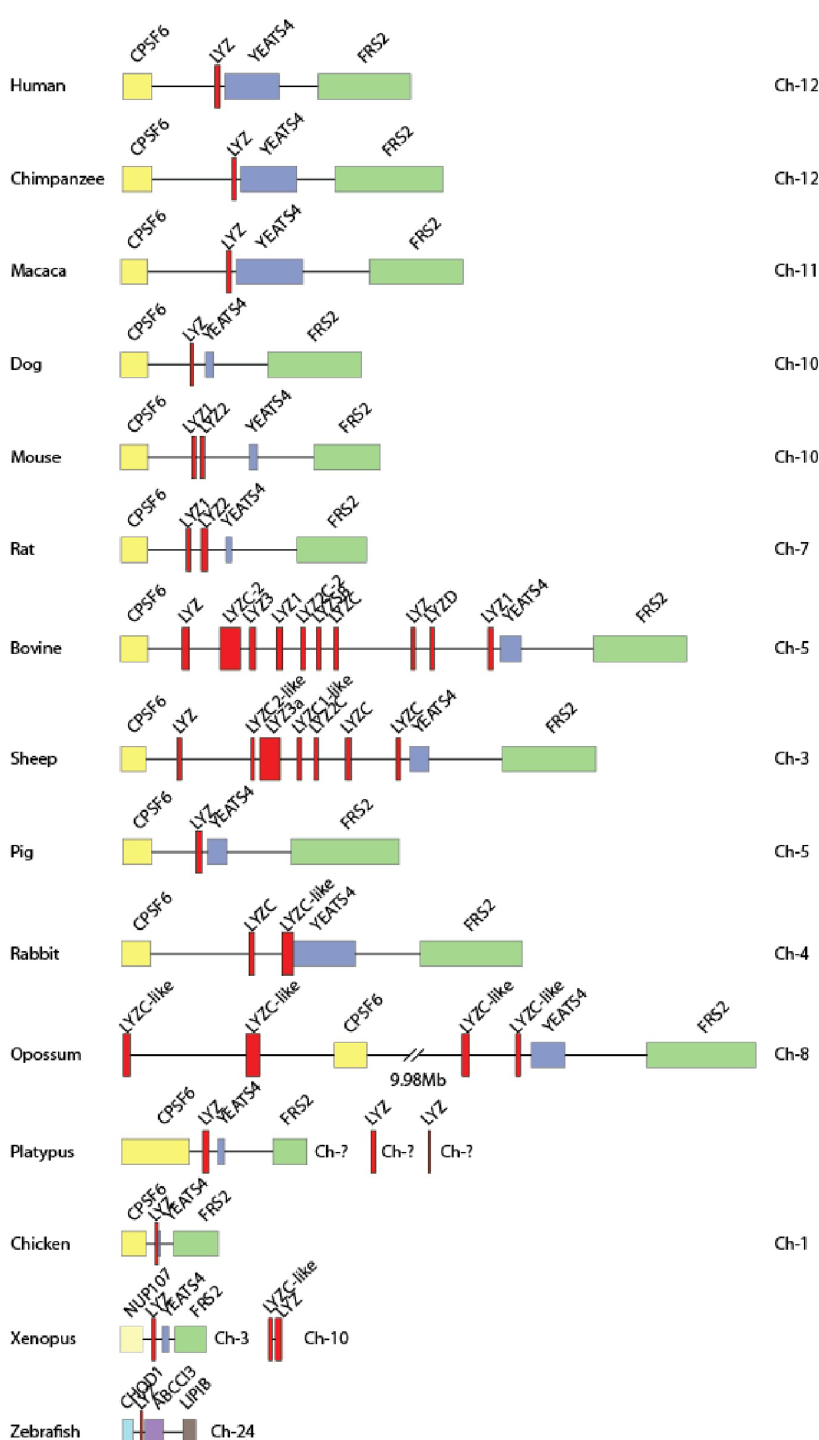
Fig 1. The lysozyme c locus. The lysozyme c locus with flanking genes are shown in scale in a panel of different vertebrate species from fish to mammals to highlight the massive expansion of lysozyme c gene that has occurred in ruminants as here represented by sheep and